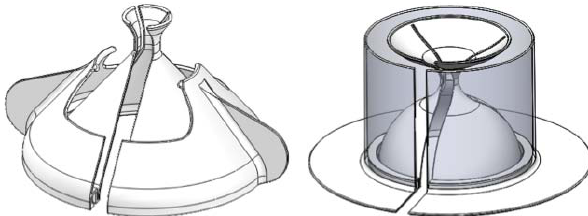
Figure 9. Conceptual designs of a shell with a narrow neck for rubber band storage. As the probe is pushed through, the rubber band is pushed o ff and snaps onto the probe over the